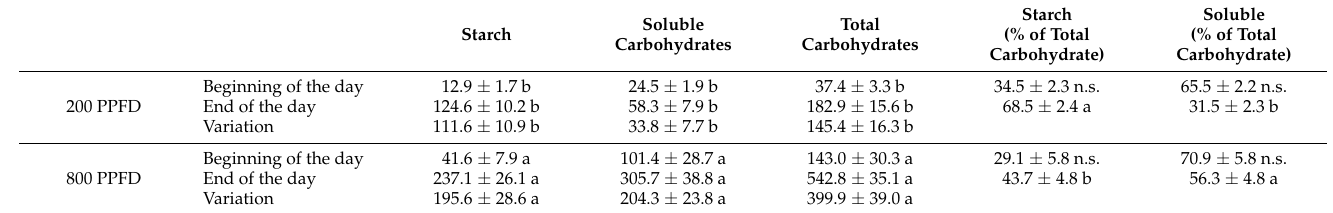
Table 3. Starch, soluble, and total carbohydrates content ( µ mol C as hexose equivalent · mg − 1